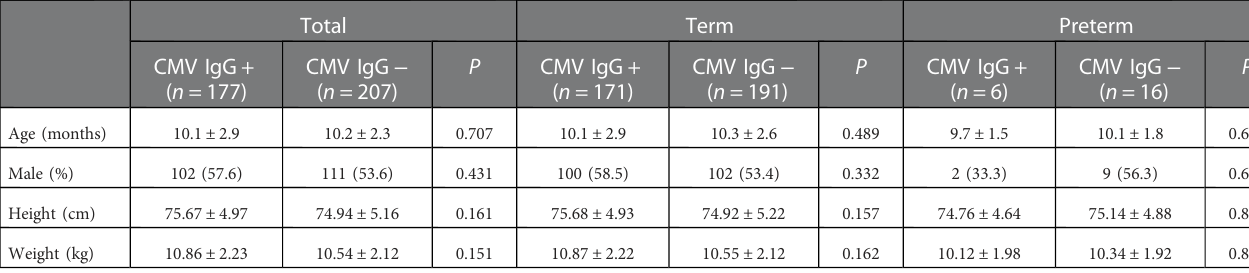
TABLE 5 Infants ’ parameters with respect to the status of cytomegalovirus (CMV) IgG. Total Term